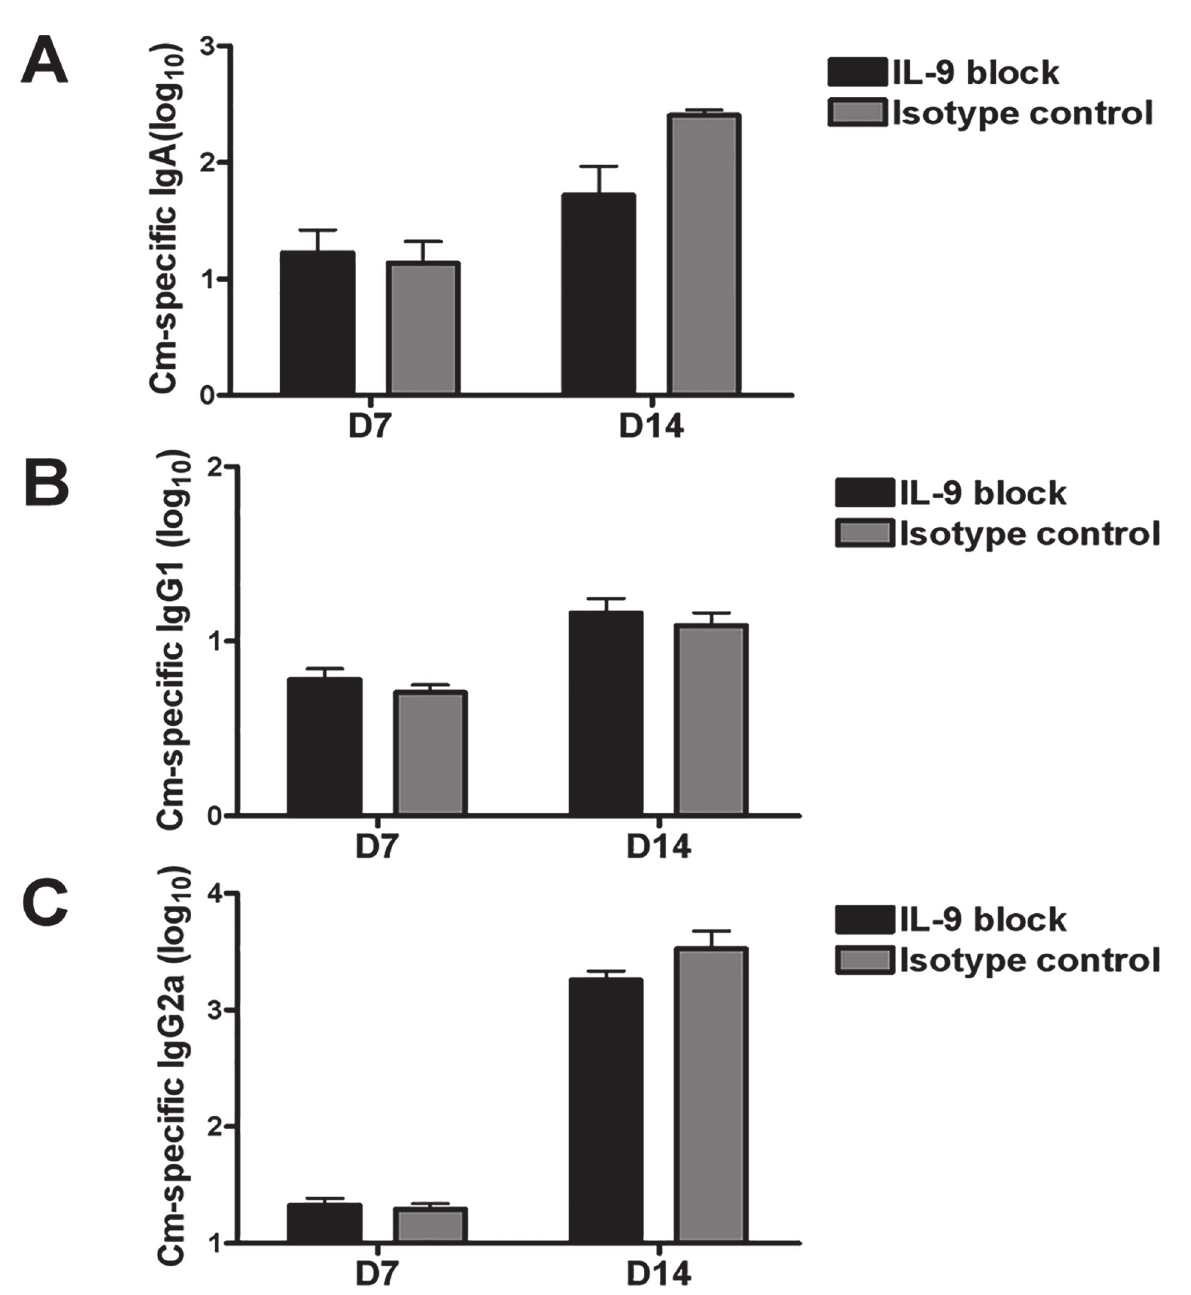
Fig 7. In vivo neutralization of IL-9 failed to alter serum Ab responses following Cm lung infection. Mice were treated 10 μ g anti-IL-9 mAb or isotype control at days -1, 0 and every two day thereafter following intranasal Cm (1×10 3 IFUs) infection. Serum samples were collected at days 7 and 14 post- infection and tested for Cm -specific IgA (A), IgG1 (B) and IgG2a (C). Ab titers were transformed to log 10 values. Pooled data for three experiments (12 mice in each group) are presented. Data is shown as mean ± SD.